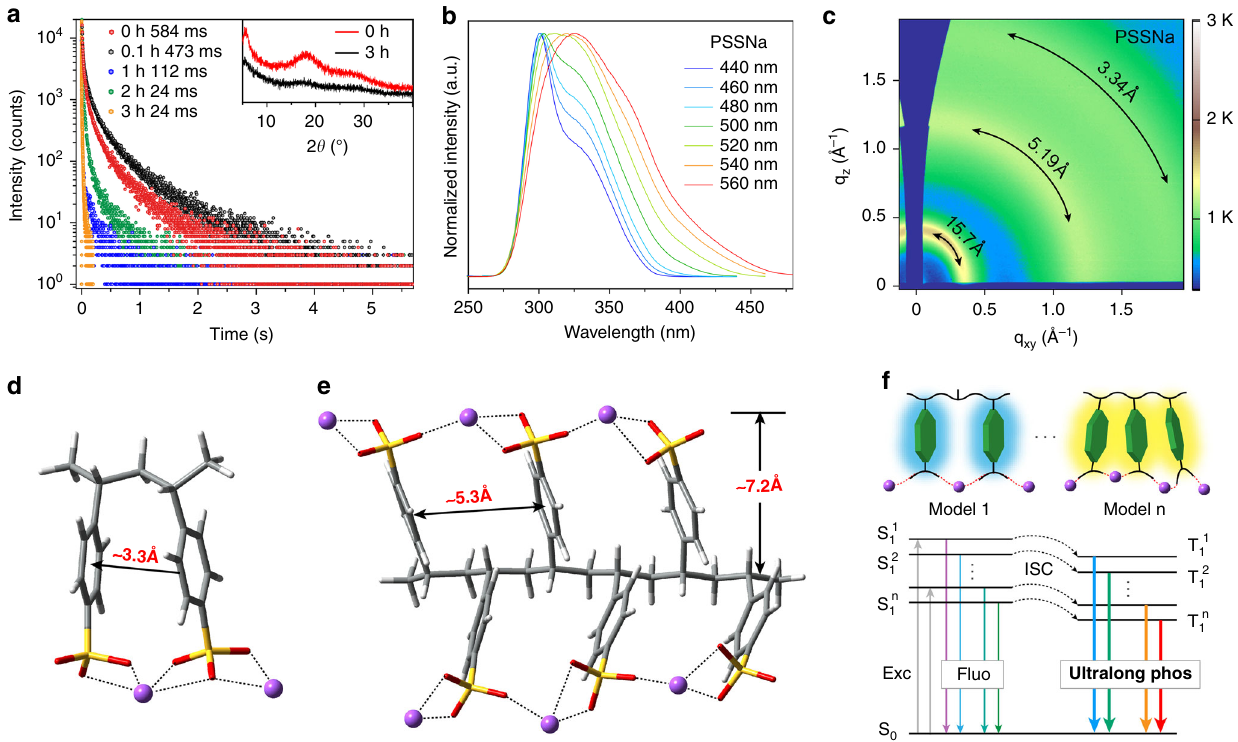
Fig. 4 A plausible mechanism for ultralong phosphorescence in polymers. a The lifetime pro fi les of PSSNa in solid monitoring at 550 nm excited by 325 nm after exposed to air (humidity: 55%) for different periods of time. Inset shows the PXRD patterns of PSSNa in solid exposed for 0 and 3 h. b The excitation spectra of PSSNa polymer monitoring 440, 460, 480, 500, 520, 540, and 560 nm at 77 K. c 2D GI-WAXS pattern of dry PSSNa fi lm. Optimized molecular structures of PSSNa models containing ( d ) two units and ( e ) six units by DFT. f Proposed mechanism for multicolor ultralong phosphorescence as the excitation wavelength changed. Noted that the schematic illustration of Model 1 and n represent the isolated and the aggregated chromophores in polymers,